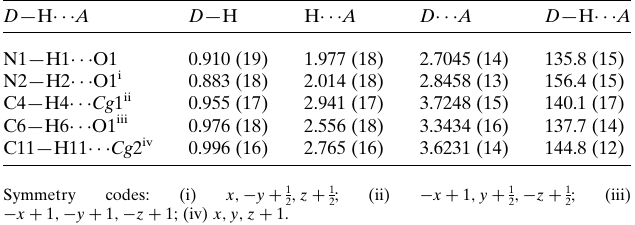
Table 2 Hydrogen-bond geometry (A˚ , (cid:3) ) for